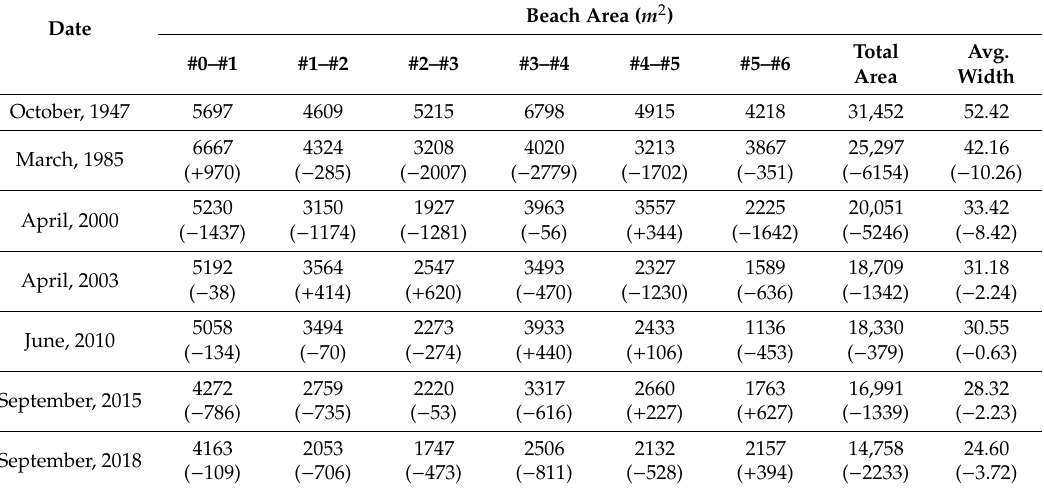
Table 7. Beach width and area of Janghang Beach.